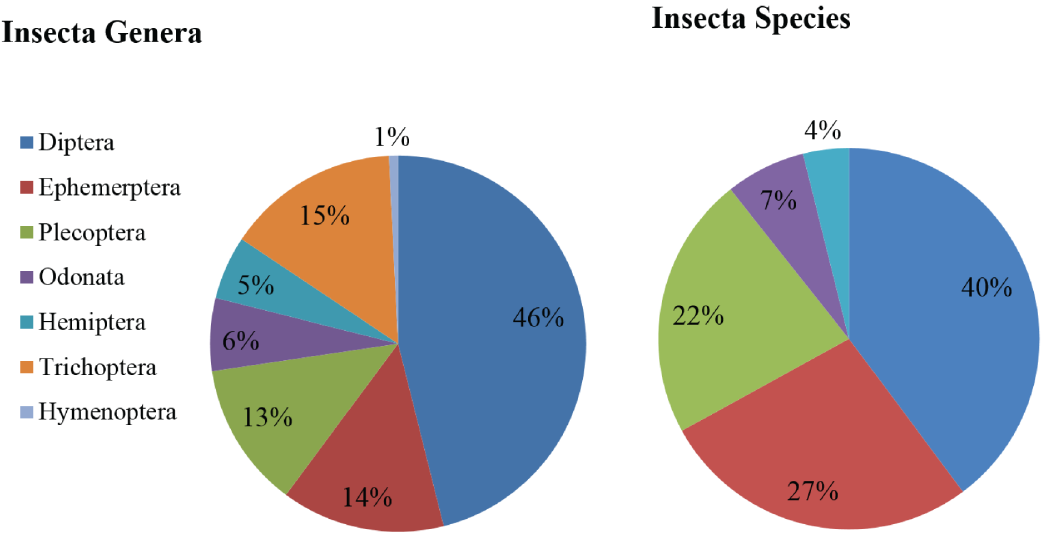
Figure 4. Percentage of genera and species belonging to insecta class recorded by 14 regions and identified from the meta-data extracted from 57